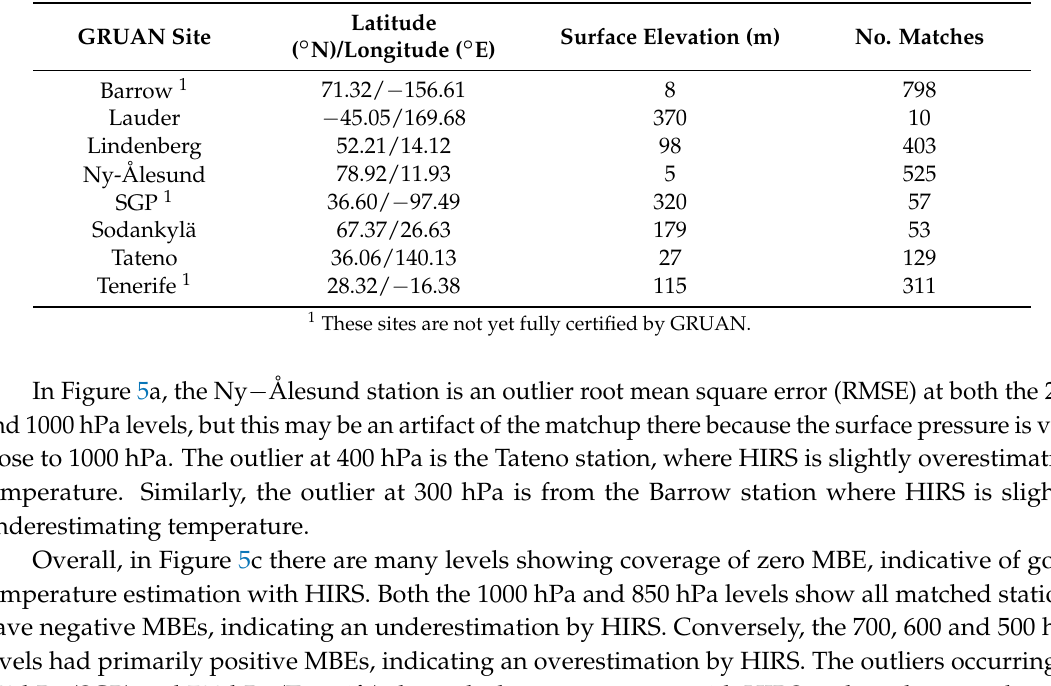
Table 3. Reference upper-air network (GRUAN) sites and locations. The number of matches count each pressure level independently, for observations between 2006 and